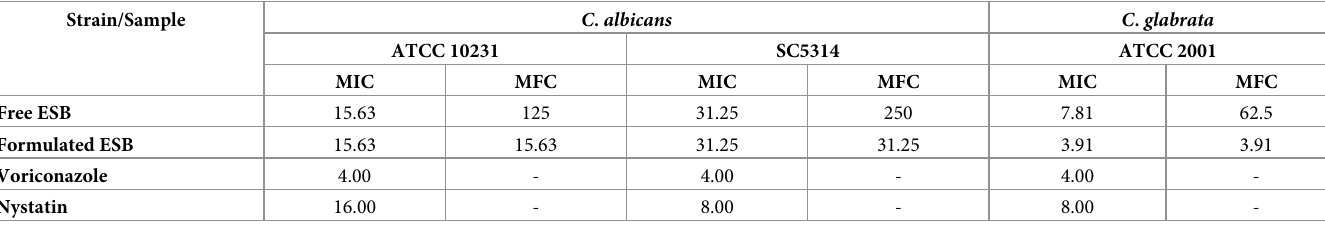
Values are in μ g/mL. ESB: E . senegalensis 70% ethanol stem bark extract; MIC: Minimum Inhibitory Concentration; MFC: Minimum Fungicidal Concentration. Experiment was carried out in